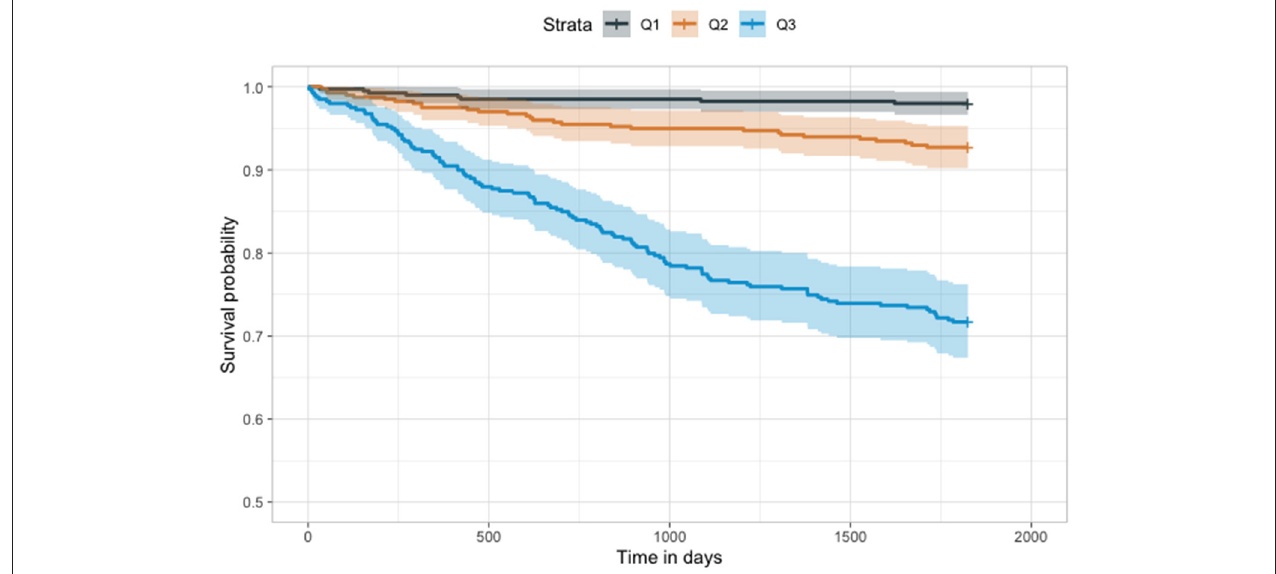
FIGURE 6 | Kaplan–Meier plot of our model. The results of our model were divided into tertiles. Higher tertiles had significantly lower survival probability ( p < 0.001).